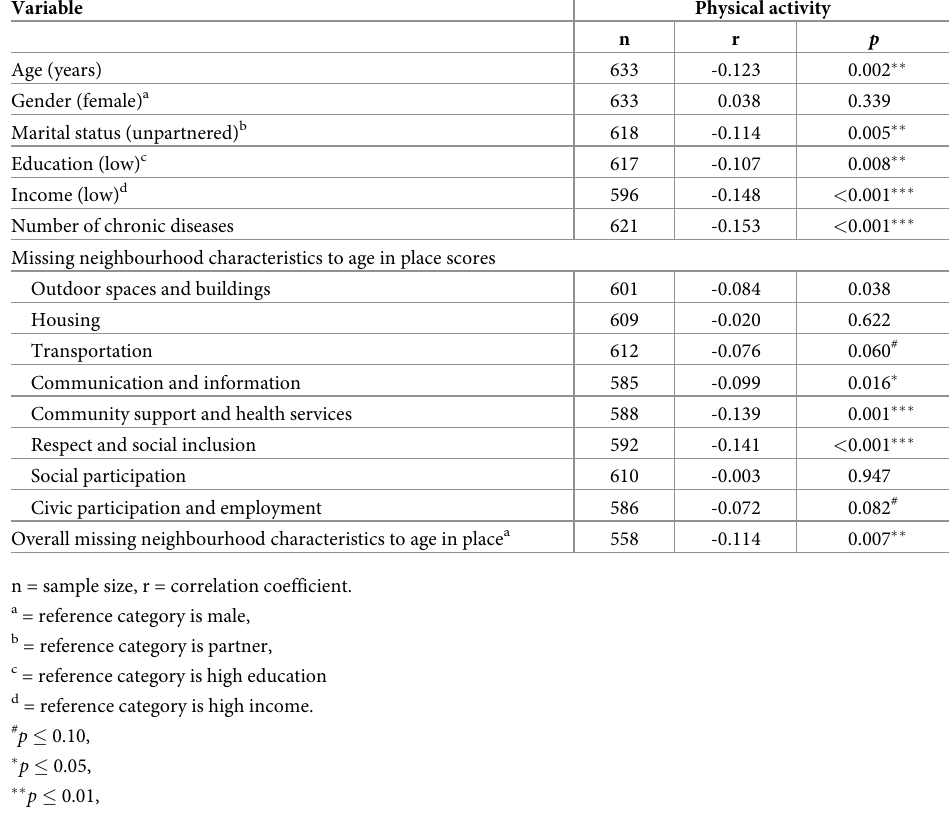
Table 2. Correlations of participant and missing neighbourhood characteristics to age in place with physical activity (n = 697).